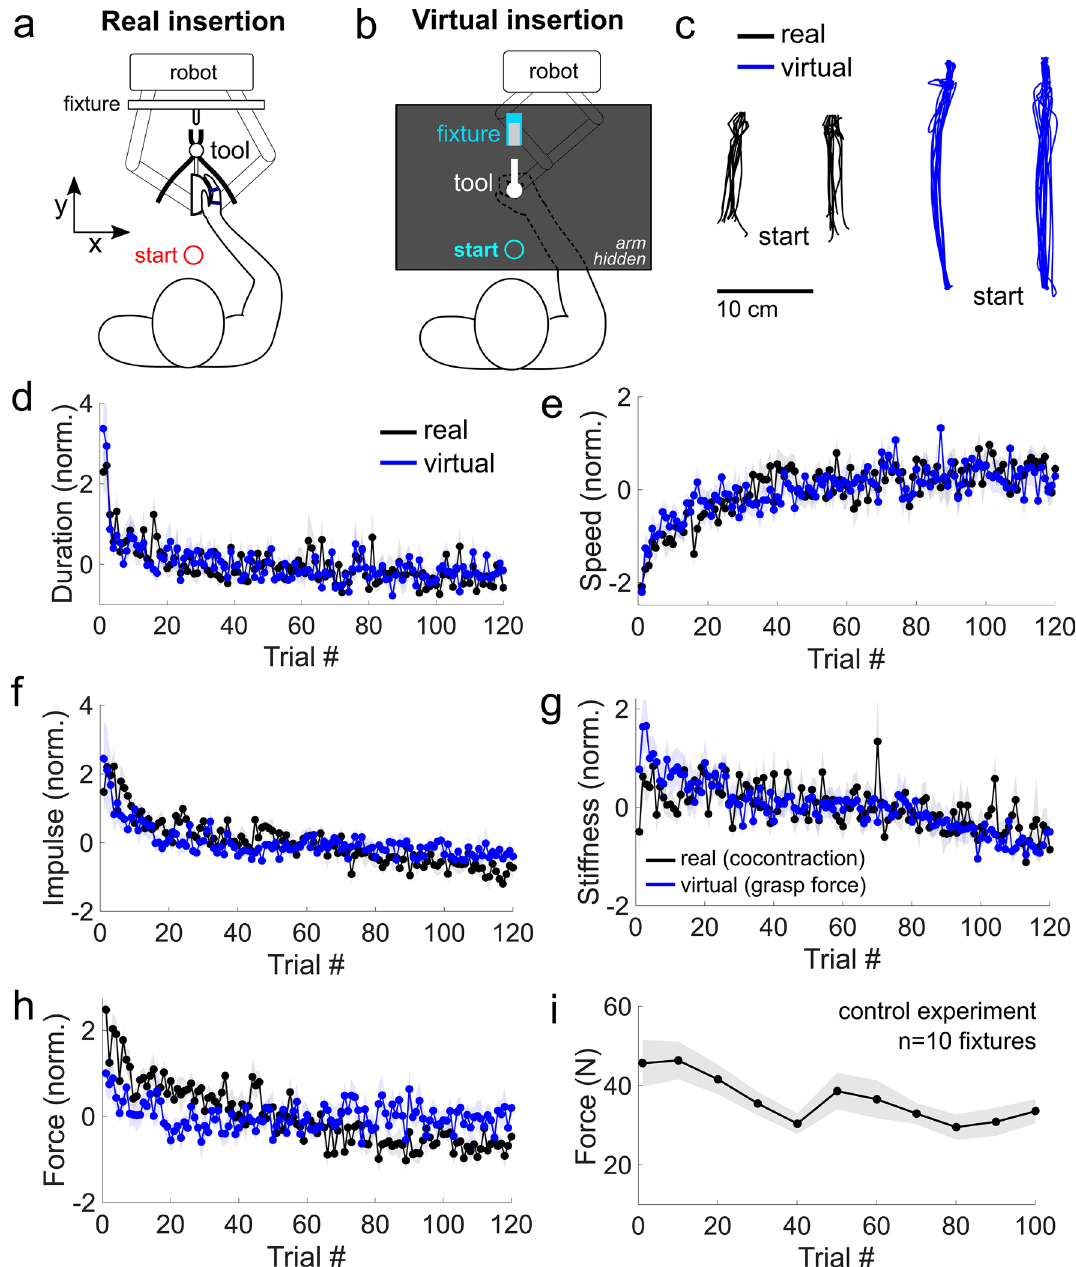
Figure 1. Comparable changes in the correlates of motor learning were observed in the real and virtual insertion task. ( a ) In the real task, the hand was strapped to the end-effector of a robot interface, to which a set of pliers and a metal clip were attached. Participants were instructed to move the hand from the start position and insert the tool into the fixture 120 times. ( b ) A separate group of participants grasped a robotic interface to insert a virtual tool into a fixture. Haptic feedback of the interaction was provided. ( c ) The hand’s trajectory in the early phase from two representative participants in the real (black) and virtual insertion (blue). The hand moved relatively straight from the start to the insertion position. ( d ) Normalized movement duration as a function of trial number in both environments. The duration dropped rapidly in the first few trials, and slowly declined thereafter. ( e ) Normalized speed increased more rapidly in the first half than in the latter half of the task. The change in the speed was comparable between the real and virtual tasks. ( f ) Normalized impulse and ( g ) normalized stiffness, estimated from average normalized muscle activity in the real task and grasp force in the virtual task, both declined as a function of trials in a comparable manner in the real and virtual environments. ( h ) Normalized force during insertion declined in the real insertion task, but not during virtual insertion. ( i ) Control experiment revealed that the force needed to insert the tool with the clip decreased with repeated insertion due to the degradation of the